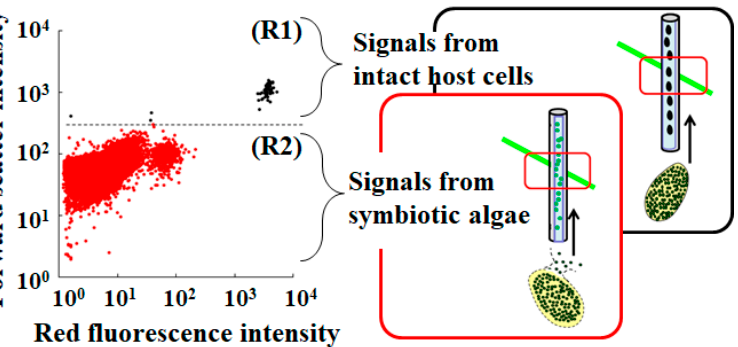
Figure 1. An example scatter plot of P. bursaria analyzed using microcapillary FCM. Signals in the R1 region with high forward scatter intensity and high red fluorescence intensity correspond to intact P. bursaria cells, while signals in the R2 region with low forward scatter intensity and low red fluorescence intensity correspond to endosymbionts released from broken P. bursaria cells.